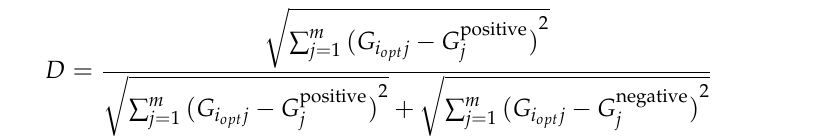
solutions. From Figure 3, in the Pareto frontiers under single-DOF optimization, (cid:101) L 1 was distributed between 0.0903 and 0.0981, and the optimal solutions with minimum ∆ (cid:101) T and (cid:101) σ of (cid:101) L 1 were on the boundary of the distribution